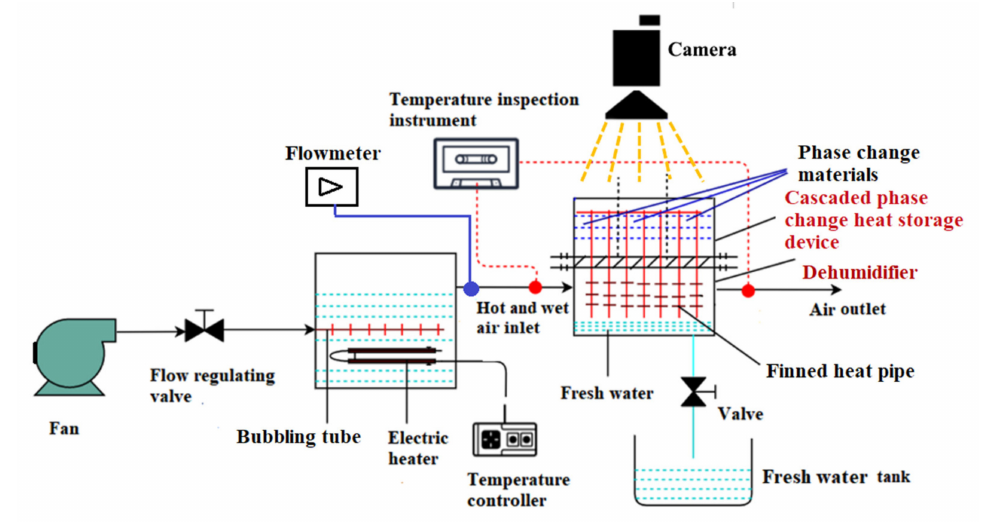
Figure 6. Experimental system of the cascaded phase change heat storage